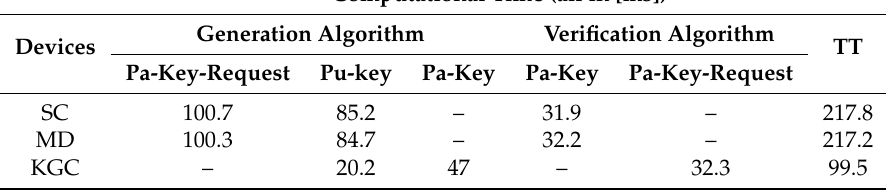
Table 2. Keys generation and verification time (in ms) in the deployment phase. Legend: SC: smart camera, MD: monitoring device, KGC: key generation center, Pa: partial, Pu: public, TT: total time. The symbol—indicates that the required action is not performed on the corresponding device for the key generation or verification.